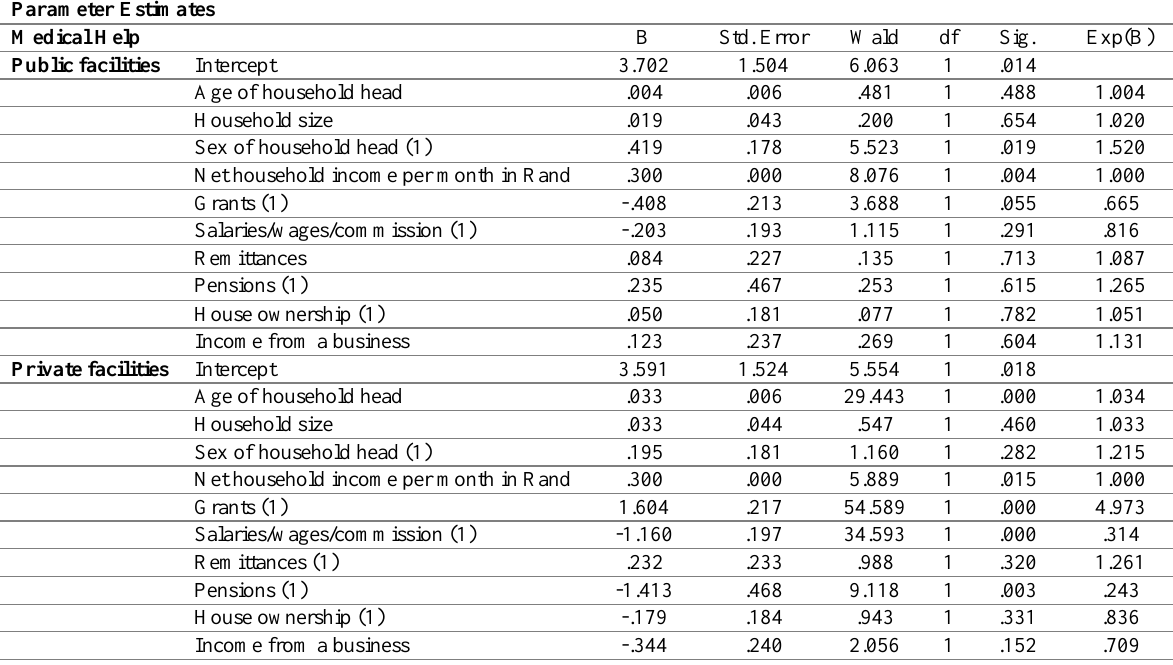
Table 4: Multinomial Logit